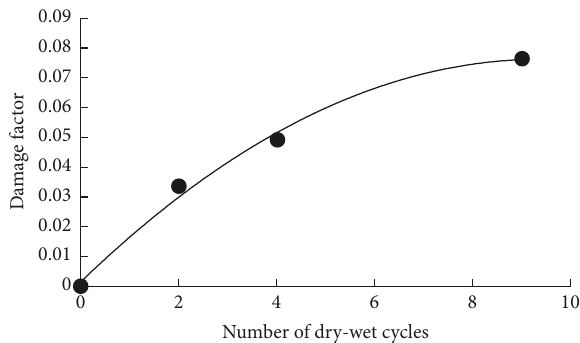
Figure 8: Variation of damage factor with the dry-wet cycles.